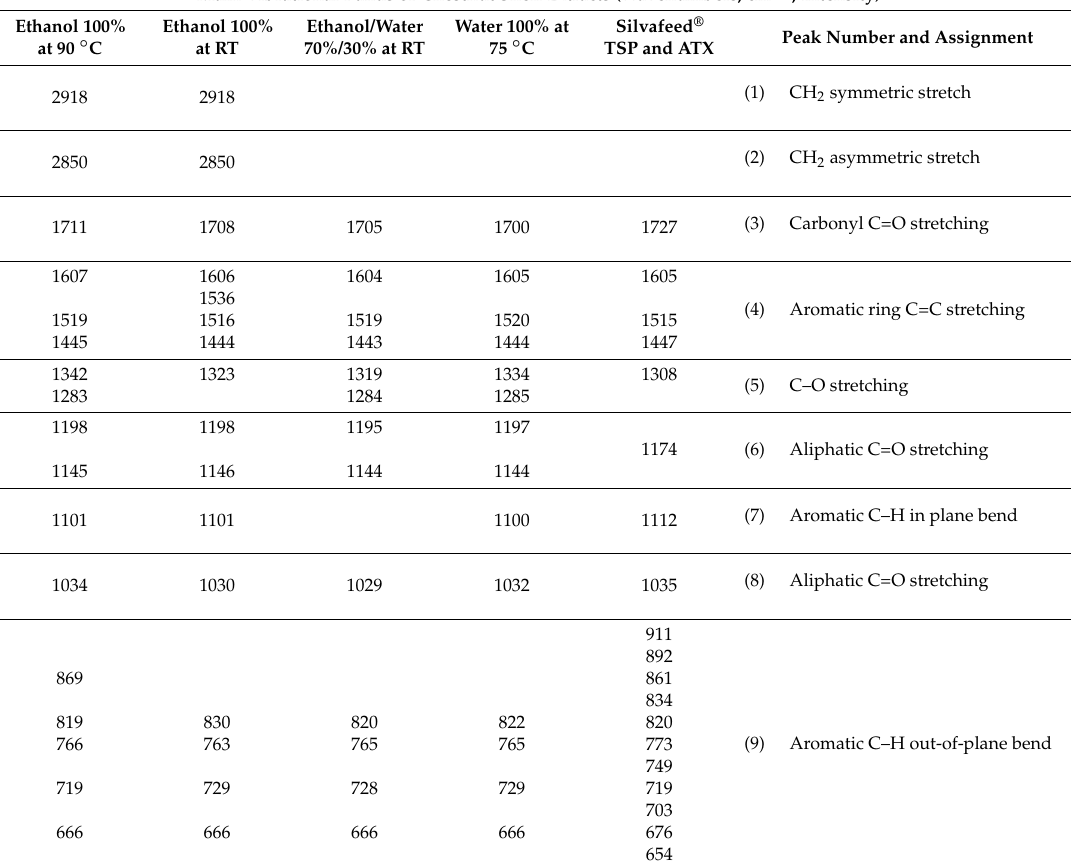
Figure 1. Attenuated total reflectance-Fourier transform infrared spectroscopy (ATR-FTIR) absorption spectra of chestnut shell extracts and chestnut wood in the wavelength 4000–650 cm − 1 . The spectra were baseline-corrected and normalized. Table 3. Functional groups and frequency assignments for polyphenolic extracts from ATR-FTIR. Assignments were according to the literature data [23–25].